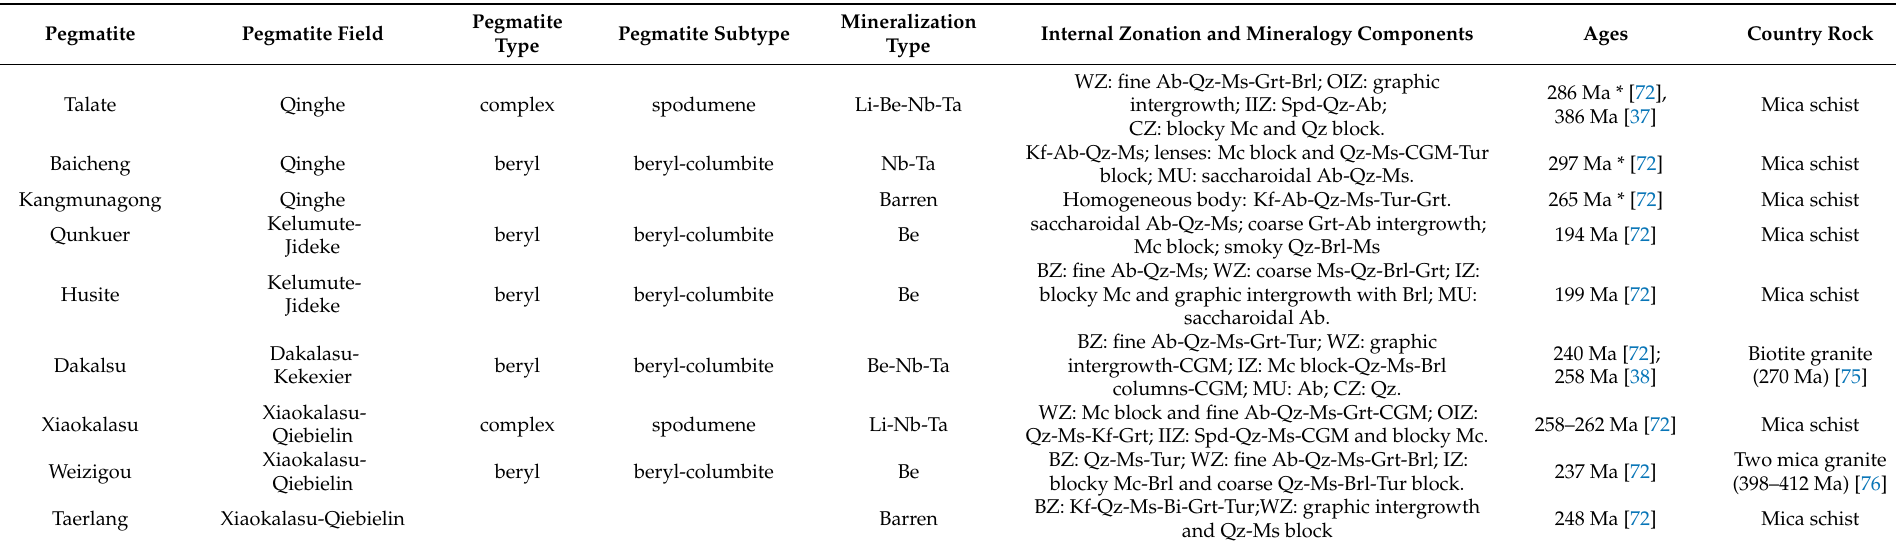
Table 1. Main characteristics of the pegmatite dykes studied in the Chinese